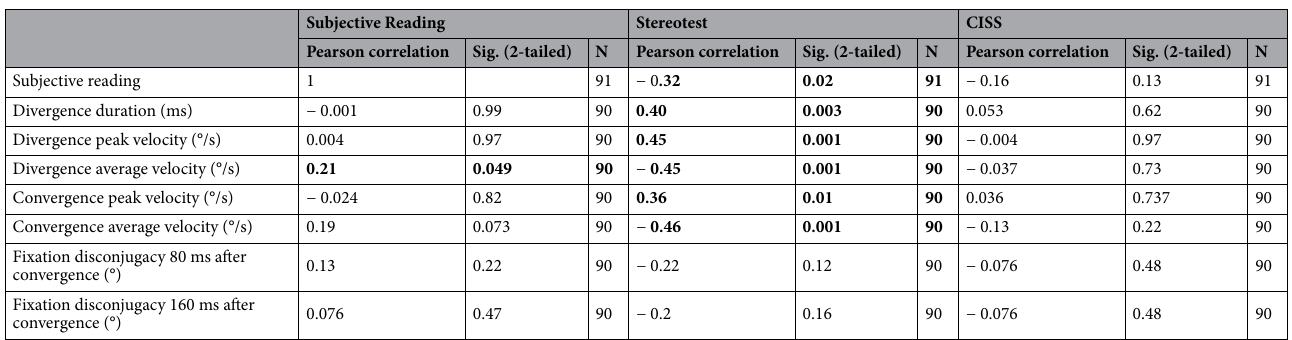
Table 6. Correlation between vergence parameters and subjective testing for all participants. Variables with significant differences between the two populations (p < 0.05) are bolded.